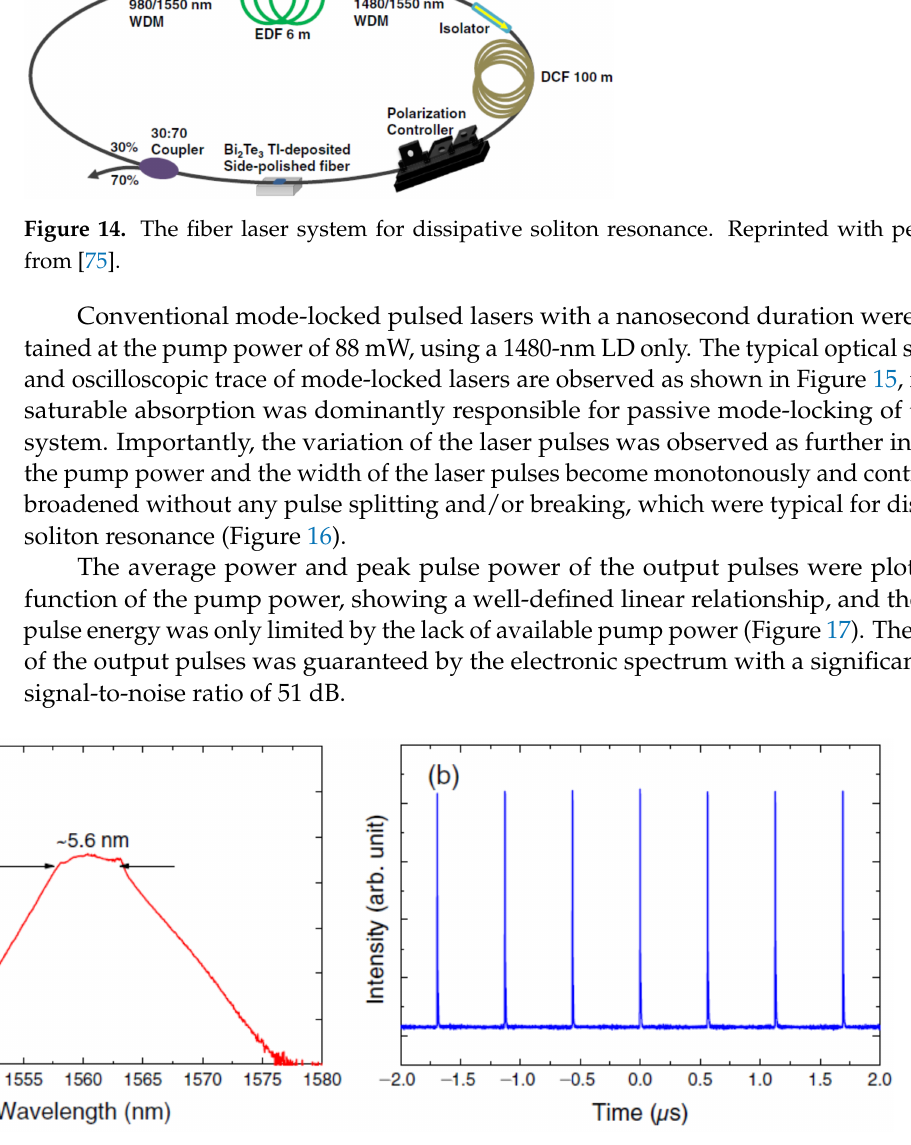
Figure 15. ( a ) Measured optical spectrum and ( b ) oscilloscope trace of the output pulses at a pump power of 88 mW. Reprinted with permission from